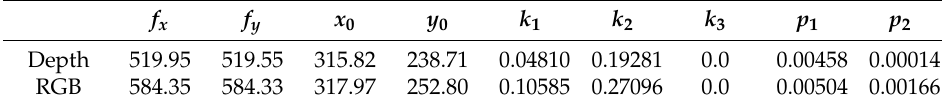
Table 1. Internal parameters of depth camera and RGB camera. The unit for f x , f y , x 0 , y 0 is pixel.